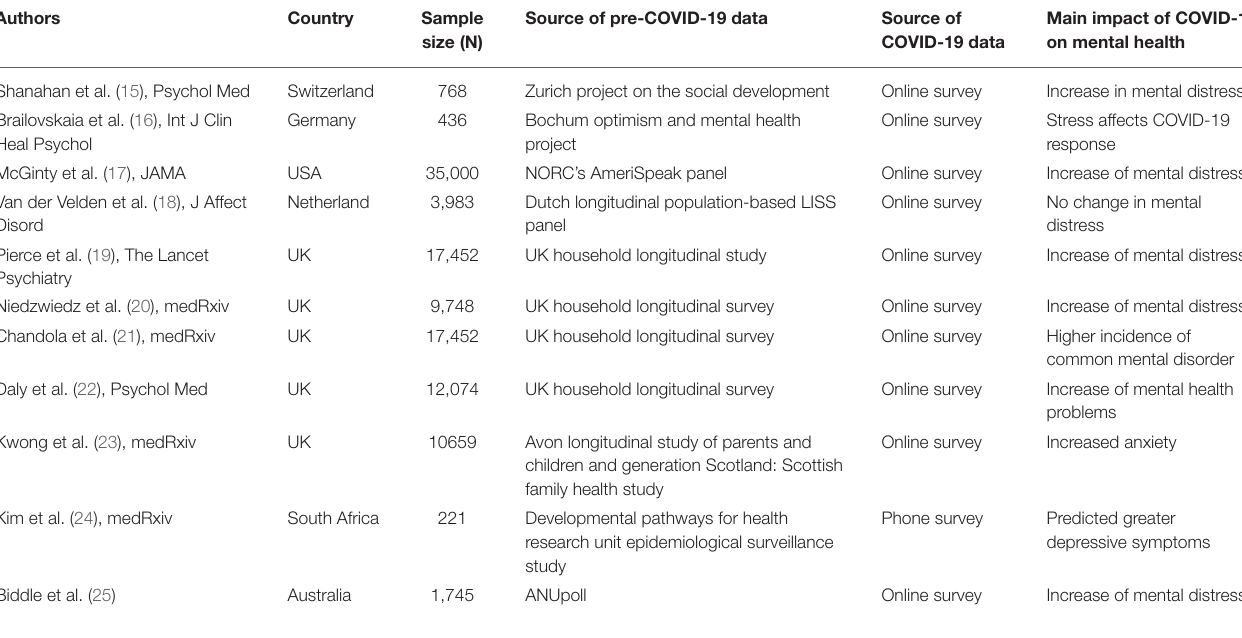
TABLE 1 | Review of current longitudinal studies on the impact of COVID-19 on mental